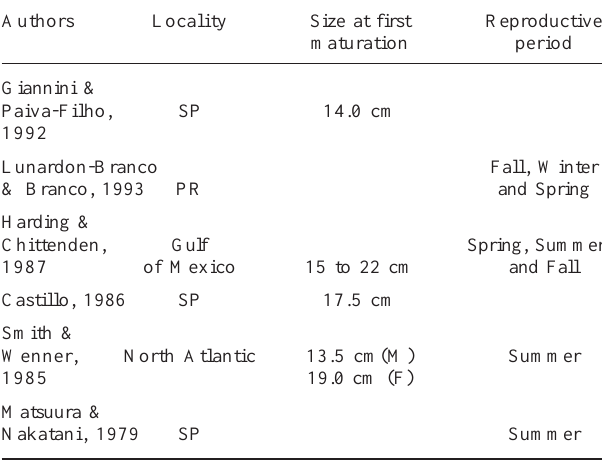
Table 1. Information synthesis for the reproductive biology of Menticirrhus americanus . M – male; F – female.